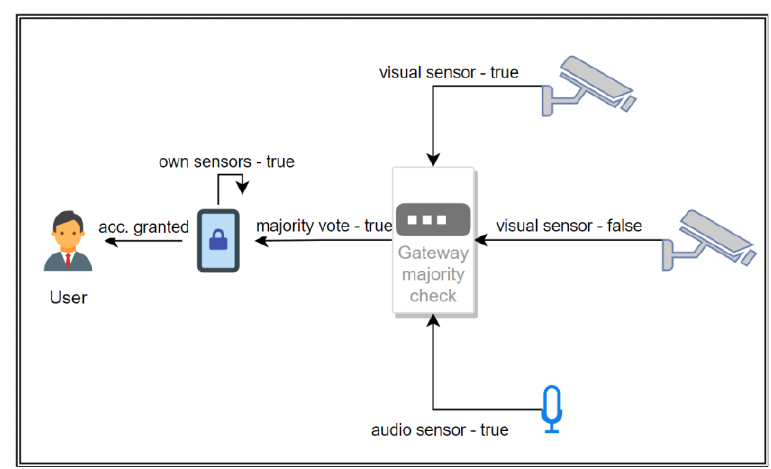
Figure 3. Distributed authentication